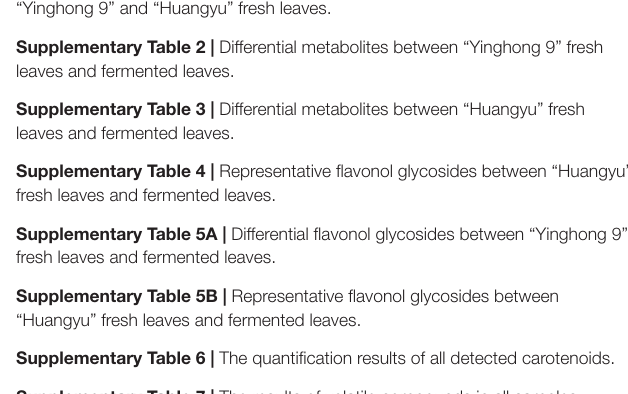
Supplementary Table 7 | The results of volatile compounds in all